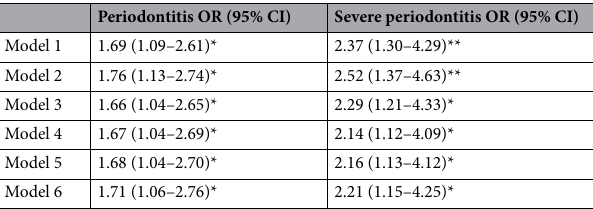
Table 3. Odds ratios (OR) and correspondent 95% confidence intervals (CI) towards bacterial vaginosis, according to the periodontal status, calculated within binary logistic regression analyses for different adjustment levels. Model 1, unadjusted model; Model 2, includes adjustment for age; Model 3, includes adjustment for age and smoking habits; Model 4, includes adjustment for age, smoking habits and BMI; Model 5, includes adjustment for age, smoking habits, BMI and diabetes mellitus; Model 6, includes adjustment for age, smoking habits, BMI, diabetes mellitus and number of systemic diseases (excluding diabetes). Statistically significant: * p < 0.05; ** p < 0.01; *** p <